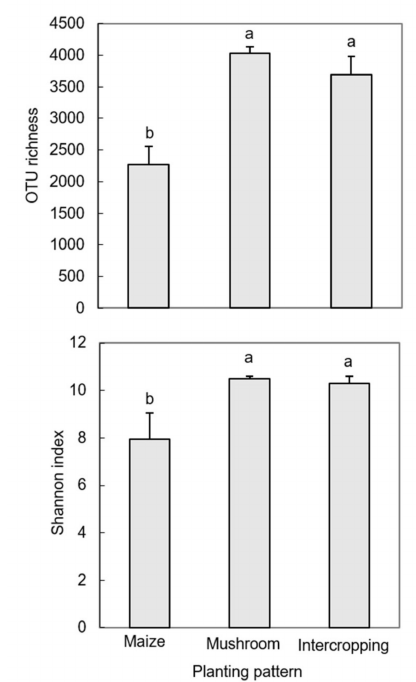
Figure 2. Operational taxonomic units (OTUs) richness and Shannon index of soil bacterial community under maize monoculture, mushroom monoculture and maize–mushroom intercropping. The error bars represent standard errors (SE). Di ff erent letters indicate significant di ff erent ( p < 0.05) according to Tukey’s test. The number of replicates per treatment is 4 ( n =